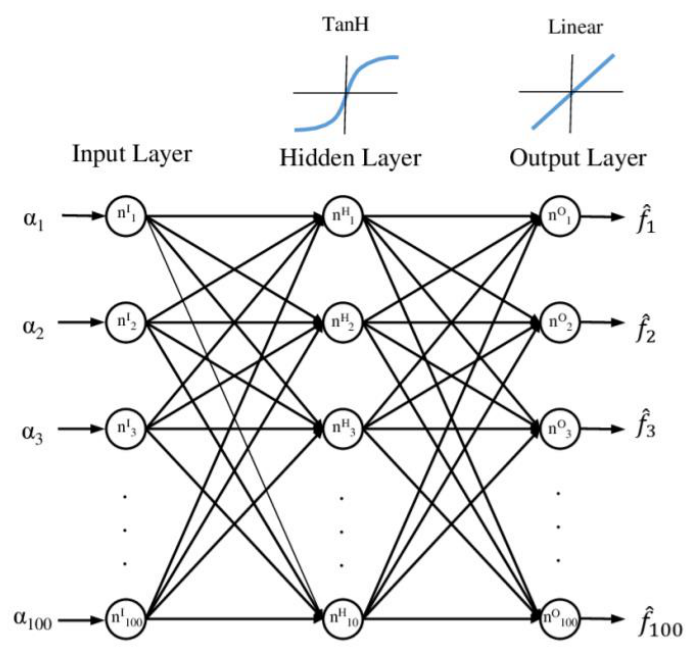
Figure 8. ANN regression model